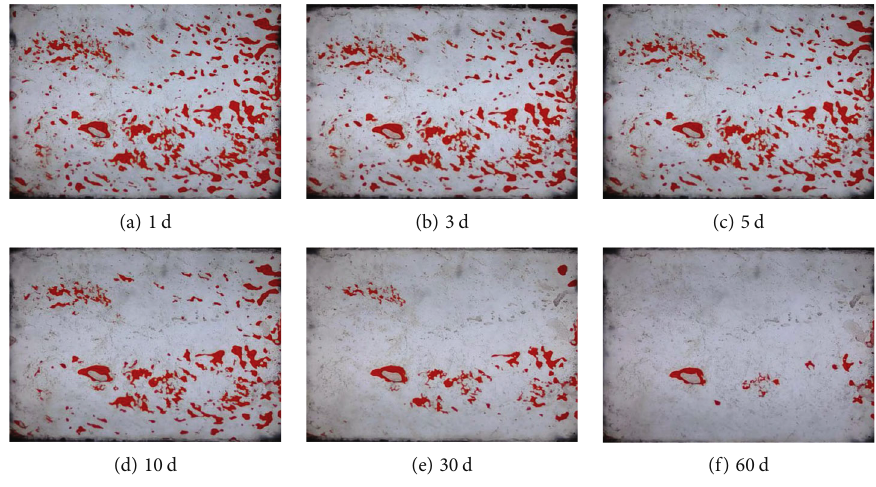
Figure 13: Dissolution process of PCE in the fracture model.